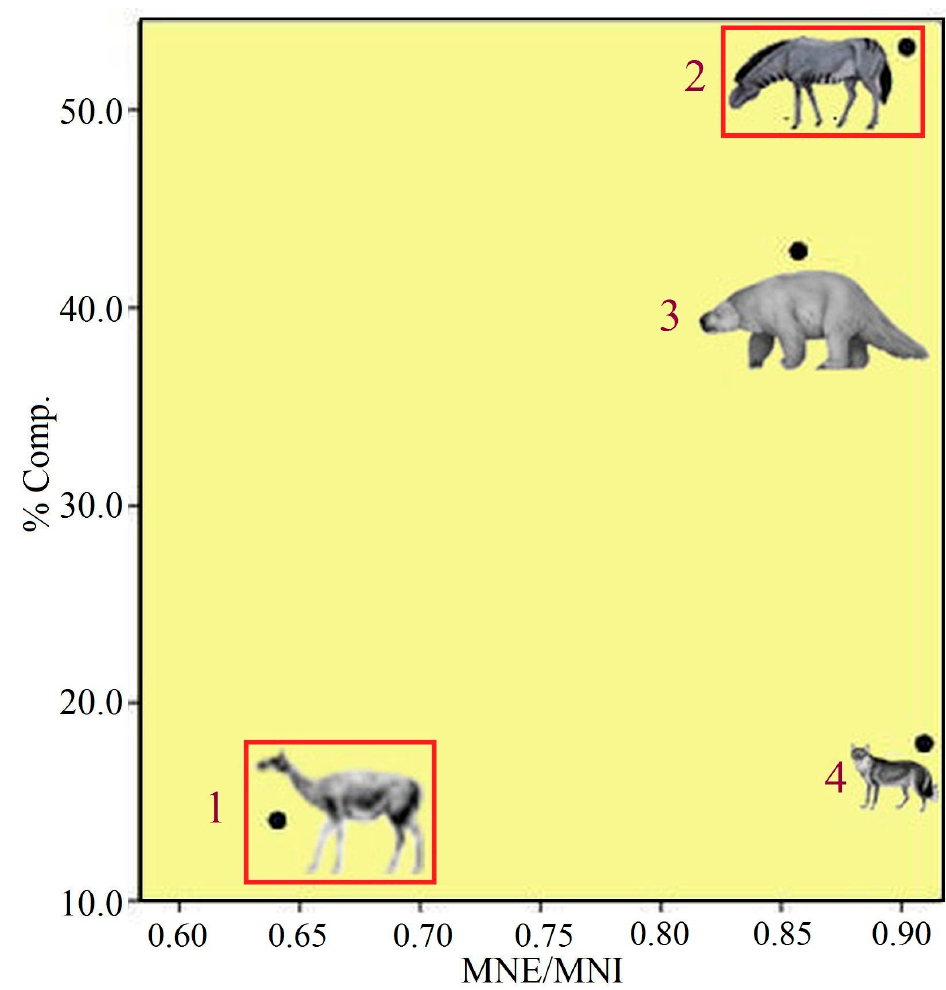
Figure 10. Relationship between the percentages of completeness (% Comp.) and the minimum number of individuals (MNI)/minimum number of skeletal elements (MNE) according to the different taxa exhumed in layer four. The rectangles show the consumed species (modified after Figure 6.2.7 of [31]). References—1: Lama Guanicoe and Lama cf. owenii , 2: Hippidion saldiasi , 3: Mylodon cf. dawinii , 4: Canidae (enclose at least Dusicyum avus ).